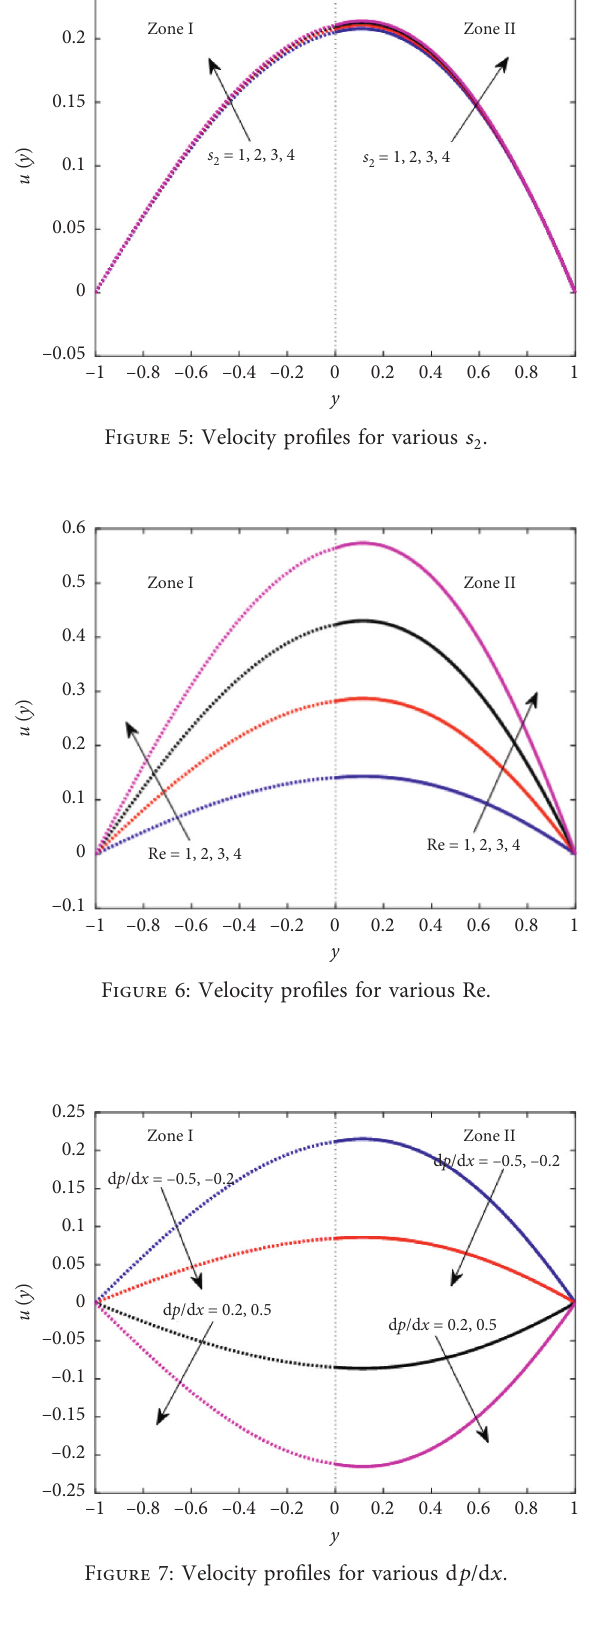
Figure 7: Velocity profiles for various d p /d x